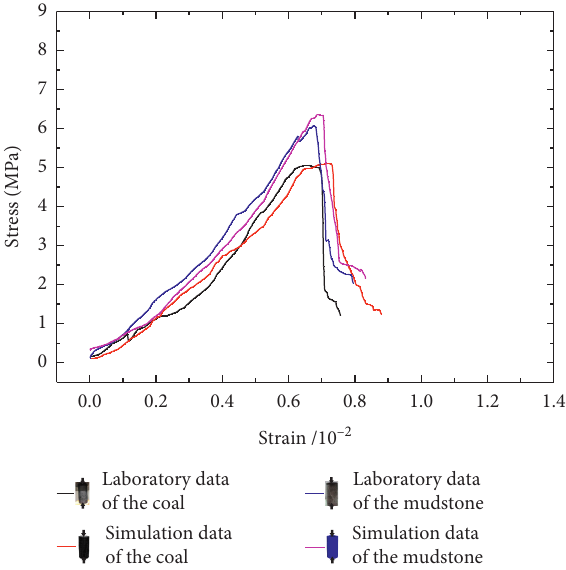
Figure 7: Stress-strain curves of the coal and